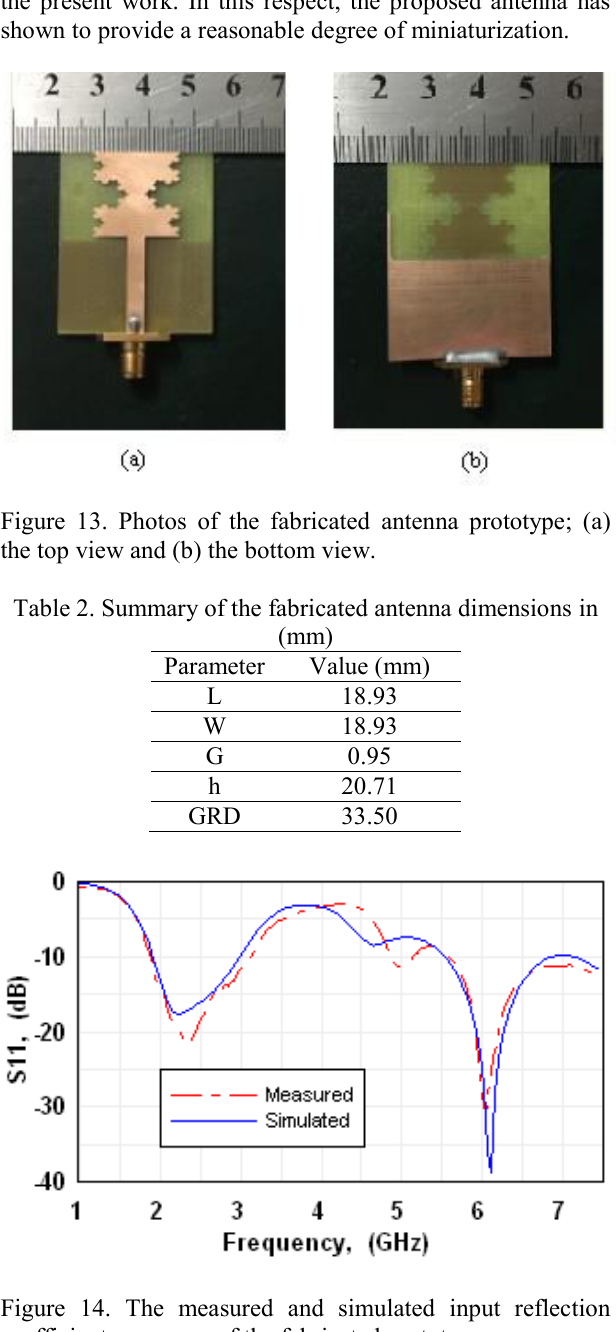
Figure 14. The measured and simulated input reflection coefficient responses of the fabricated prototype